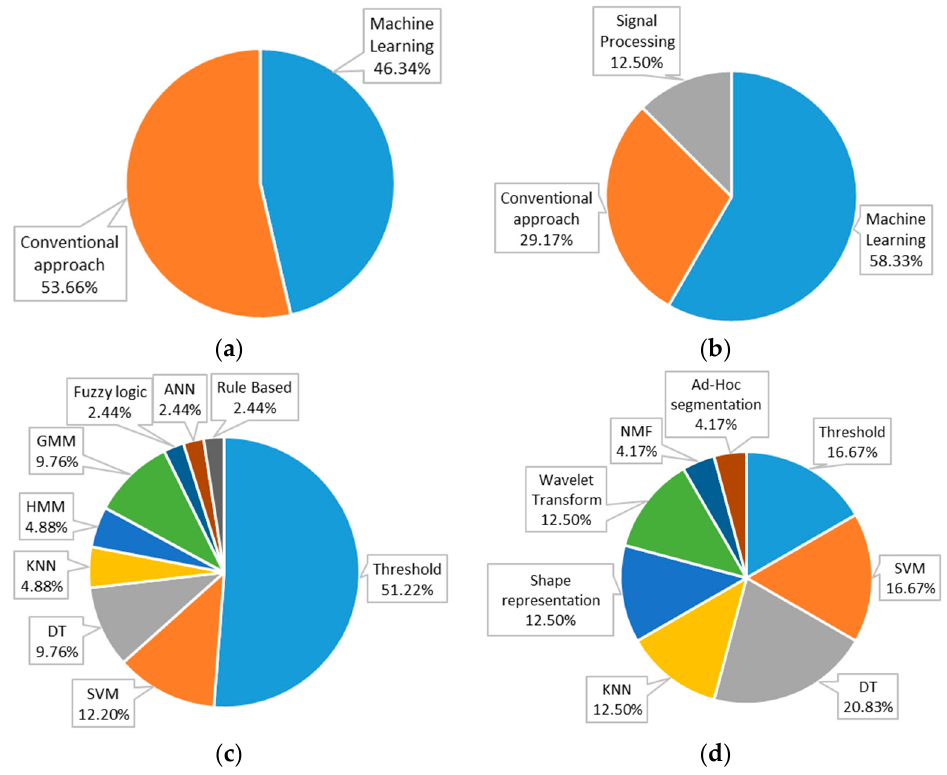
Figure 2. Tendency of algorithms used in fall detection system: ( a ) main categories of algorithm used before 2014; ( b ) main categories of algorithm used before 2014; ( c ) detailed categories of algorithms used before 2014; and ( d ) detailed categories of algorithms used after 2014. Noted that some fall detection systems use two algorithms.